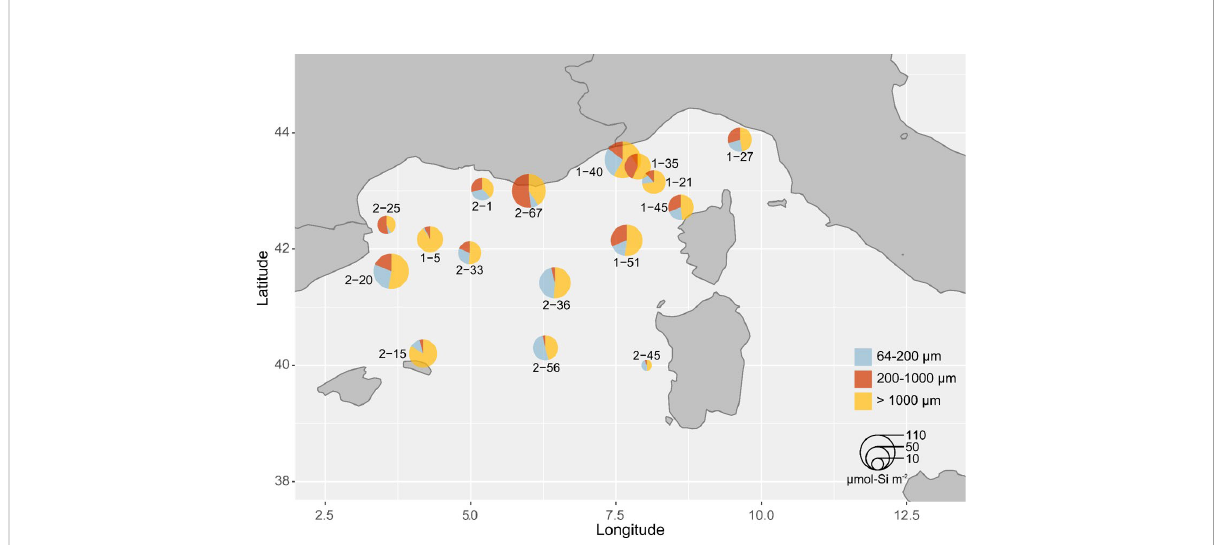
FIGURE 4 Overview of the bSi biomass of Rhizaria integrated into the upper 500 m of the water column (µmol-Si m -2 ) in the Mediterranean Sea. Piecharts indicate relative contributions of the three size classes studied to the total bSi at each station and their size is proportional to their Si contribution.